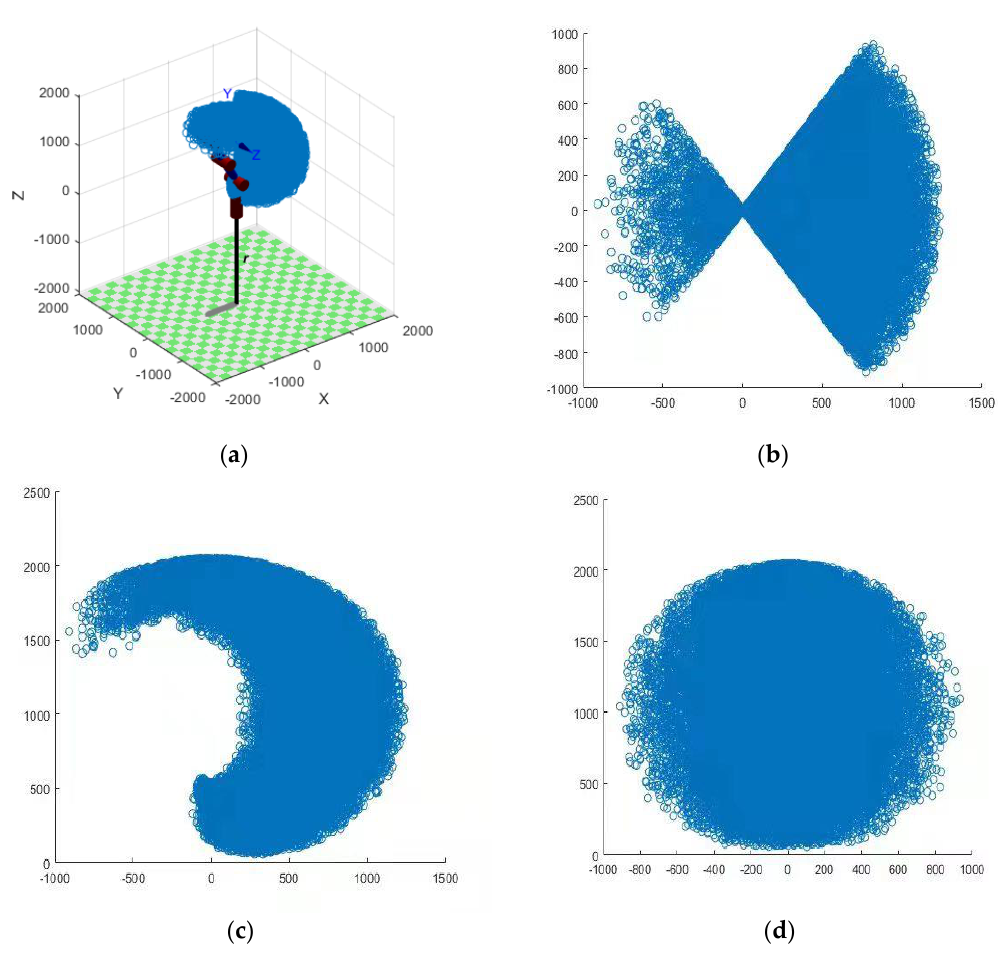
Figure 7. Cloud diagram of the pollen-picking manipulator workspace. ( a ) 3D − space cloud diagram: ( b ) X/Y − plane projection; ( c ) X/Z − plane projection; ( d ) Y/Z − plane projection. ( b ) X/Y − plane projection; ( c ) X/Z − plane projection; ( d ) Y/Z − plane